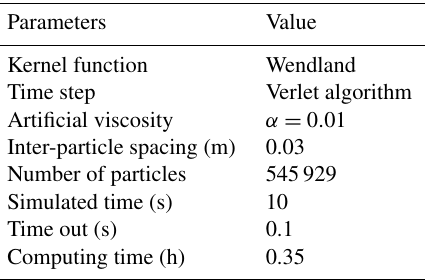
Figure 23. Sea surface elevation obtained after a simulation time of 1min. Table 11. Parameters and main characteristics of the SPH simula- tion.